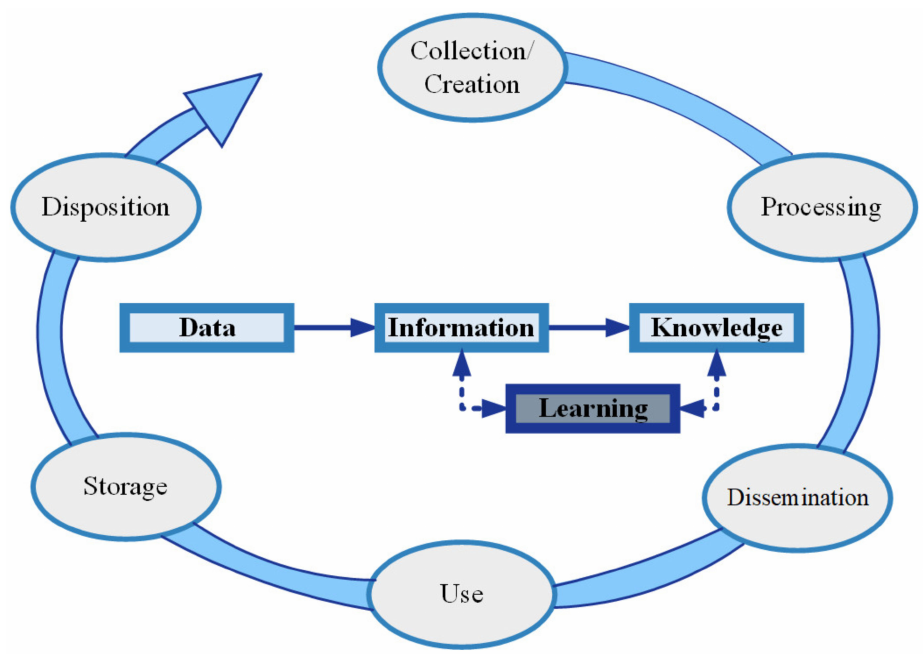
Figure 4. The process-based perspective of data, information, knowledge, and learning based on